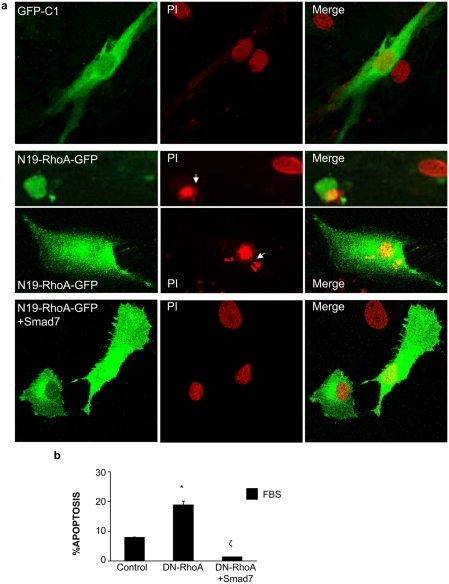
Smad7 inhibits DN-RhoA induced apoptosis.Cells grown in 10%FBS were transfected with a GFP overexpressing vector or with a vector that overexpresses DN-RhoA fused to GFP (N19-RhoA-GFP). Some cells were cotransfected with a Smad7 overexpressing vector. After 48h of transfection apoptosis was evaluated. Figure a shows representative cells (confocal microscopy). Cells were fixed and stained with propidum iodide and mounted in mowiol. Apoptotic nuclei are bright, condensed and present nuclear bodies in the cytoplasm (arrows) and transfected cells appear in green. Figure b shows the percentage of hypodiploid cells expressed as mean±SEM of 4 experiments. *p<0.05 vs. control ζ p<0.05 vs. DN-RhoA transfected cells.